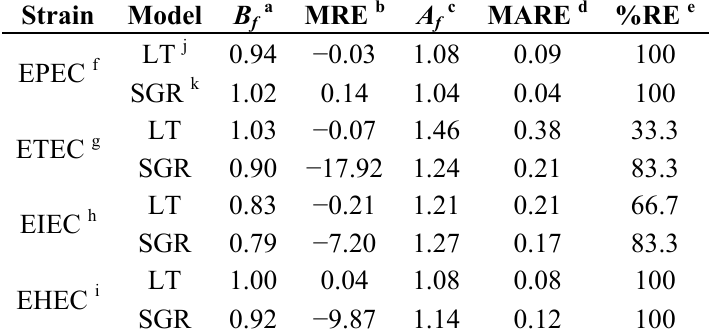
Table 3. Performance of secondary growth models for E. coli O157:H7 in perilla leaves for various pathogenic E. coli strains.